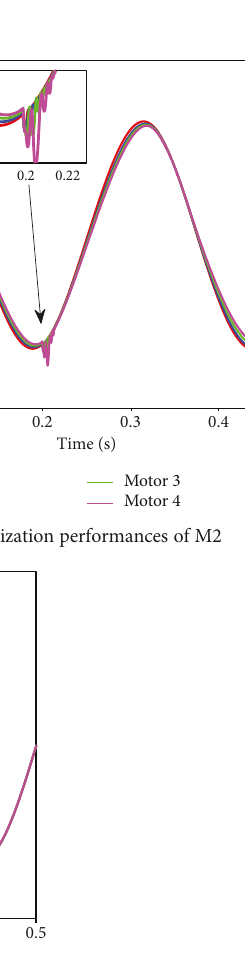
Figure 9: Control inputs.